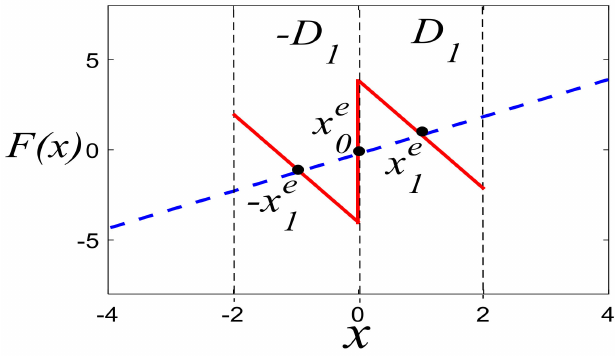
Figure 5. F ( x τ ) and its characteristic regions of chaotic 2–scroll attractor.